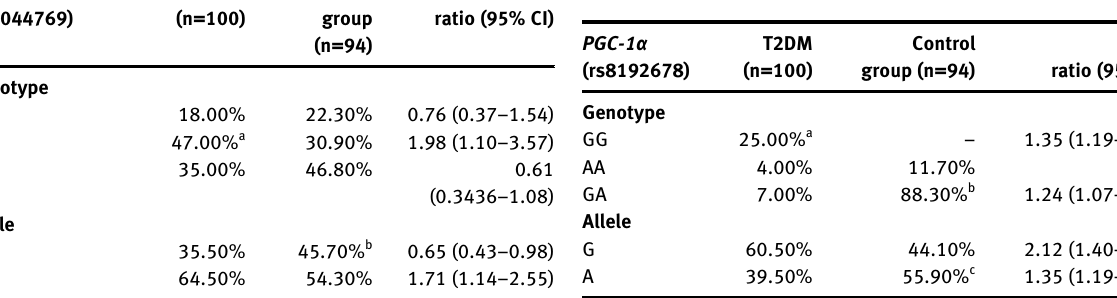
Table  : Distribution of PGC-  α (rs  ) genotypes and alleles in type  diabetes mellitus patient and control